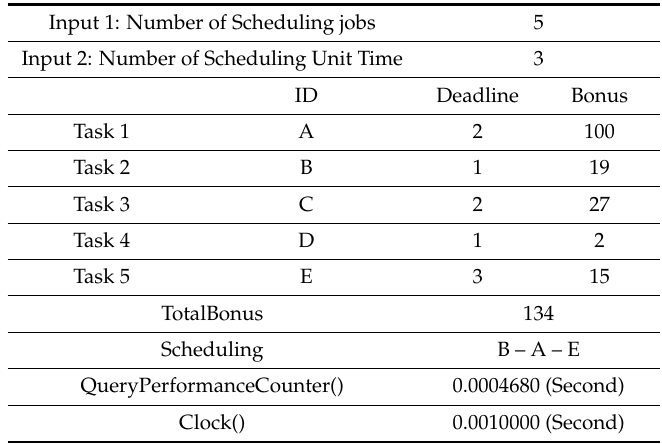
Table 2. Execution Result. (The result of scheduling task using a greedy algorithm and the